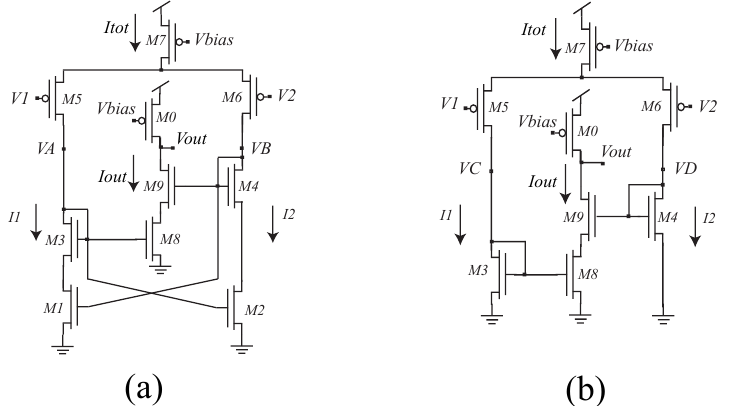
Figure 8. Schematic of ( a ) the proposed bump circuit and ( b ) the classic bump circuit presented by Tobias